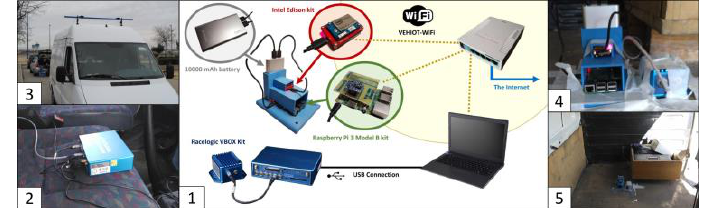
Figure 1. Hardware and connectivity ( 1 ); Racelogic VBOX data logger ( 2 ); van equipped with GPS dual-antenna ( 3 ); low-cost kits and Racelogic VBOX IMU ( 4 , 5